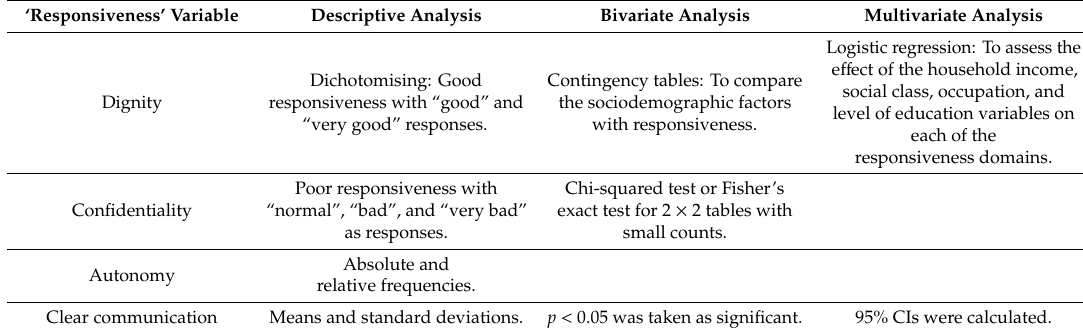
Table 2. Statistical